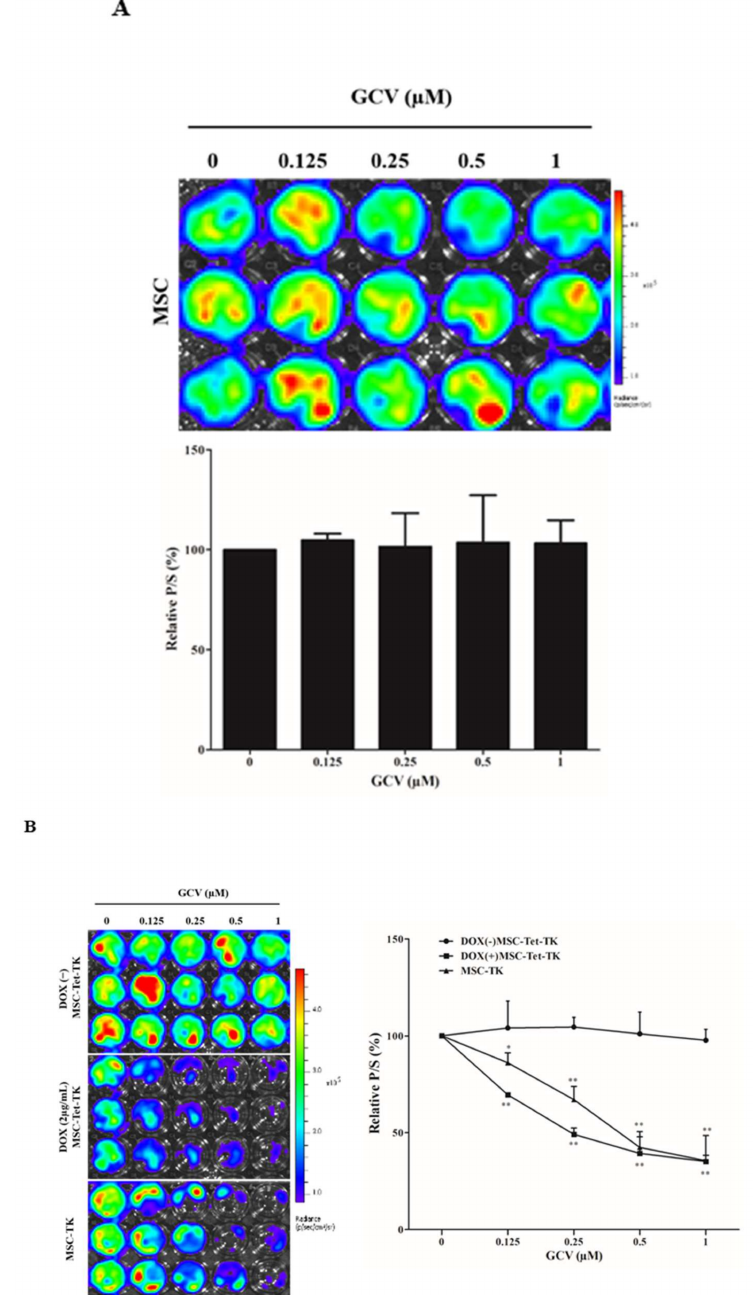
Figure 3. Bystander effect of MSC-Tet-TK and MSC-TK cells. ( A ) Rluc activity in co-cultures (1:1) of naive MSCs and CT26/Rluc cells treated with the indicated concentrations of GCV for 48 h. ( B ) BLI images of the Rluc activity and quantitation data of CT26/Rluc in co-cultures (1:1) of MSC-TK or MSC-Tet-TK cells in the absence or presence of doxycycline (DOX( − ) and DOX 2 µ g/mL respectively). Three individual experiment values are expressed as the mean ± standard deviation (SD), * p < 0.05, ** p < 0.01, *** p < 0.001 (by Student’s t test). p/s,